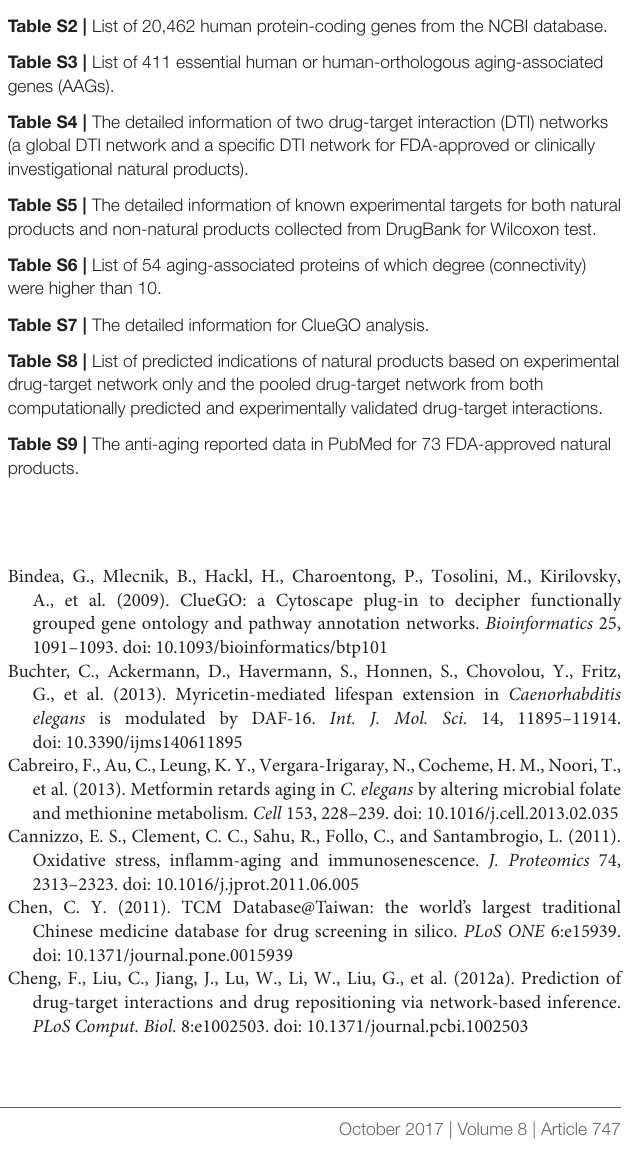
Table S1 | List of 1,460 curated aging-associated genes (AAGs) across five organisms. Table S2 | List of 20,462 human protein-coding genes from the NCBI database. Table S3 | List of 411 essential human or human-orthologous aging-associated genes (AAGs). Table S4 | The detailed information of two drug-target interaction (DTI) networks (a global DTI network and a specific DTI network for FDA-approved or clinically investigational natural products).